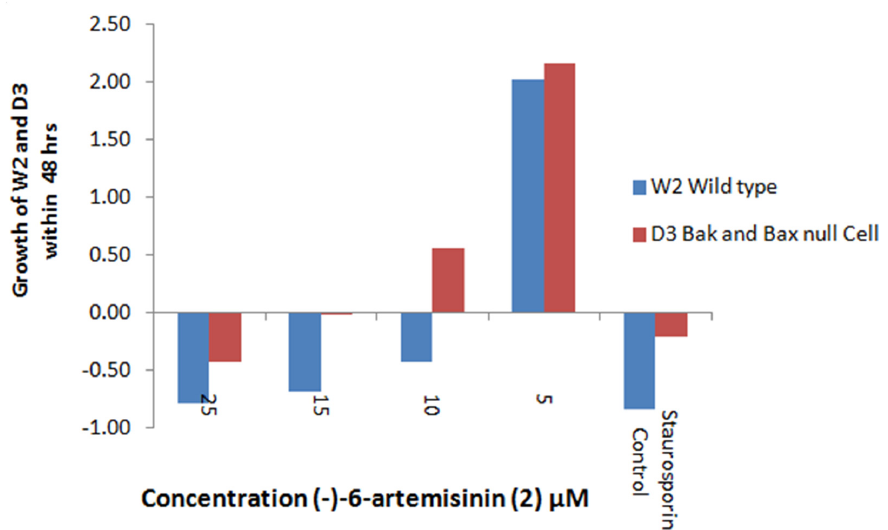
Figure 6. Induction of apoptosis of ( − )-6-epi-artemisinin ( 2 ) with IC 50 of 11 ± 0.71 µ M.